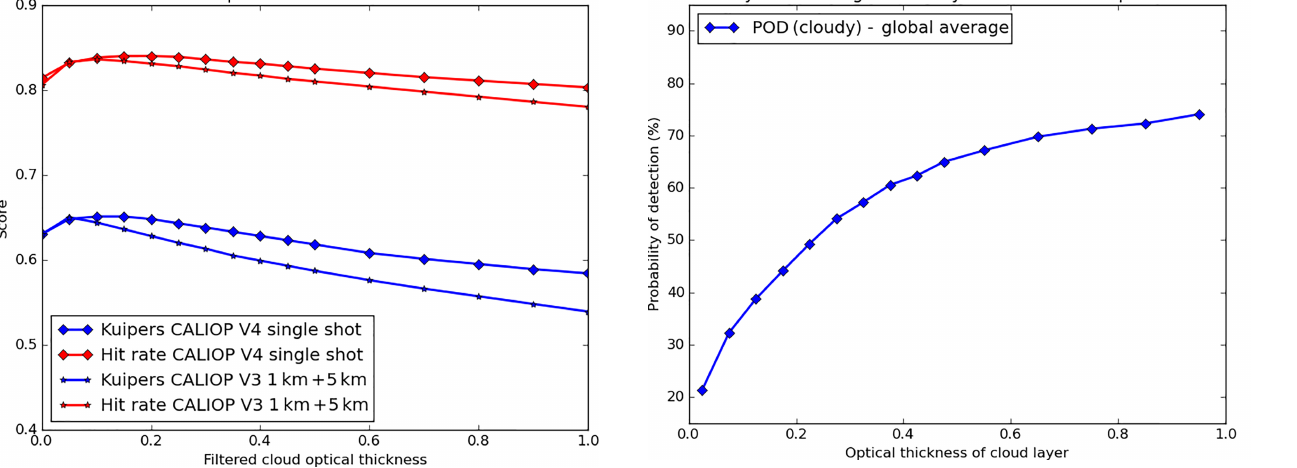
Figure 4. CALIOP-based validation scores (hit rate and Kuipers) as a function of filtered cloud optical thickness (see text for expla- nation) for 80 matched NOAA-18 orbits between October and De- cember 2006. The curves compare results based on CALIOP ver- sion 4.10 CLAY products computed with the new method based on single-shot information (denoted “CALIOP V4 single shot”) with results based on CALIOP version 3.01 CLAY products computed with the old method based on combined 1 and 5km data (denoted “CALIOP V3 1 and 5km”).